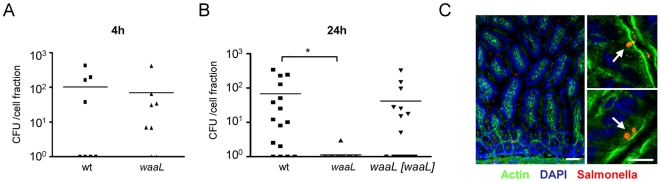
Early epithelial stimulation restricts the number of intraepithelial Salmonella in vivo.Colony forming units (CFU) cultured from isolated highly pure (>98% E-cadherin+/CD45−) intestinal epithelial cells (IEC) (A) 4 h (n = 8 mice per group) and (B) 24 h (n = 16 mice per group) after oral infection of Balb/c mice with 1×108 CFU wildtype (wt), waaL-deficent (waaL), and complemented waaL [waaL] Salmonella. *, p<0.05. (C) Immunostaining for S. Typhimurium O-antigen (anti-O4 and anti-O5) in intestinal tissue sections obtained from orally infected mice. Magnification, Bar 50 µm (left panel) and 5 µm (right panel).